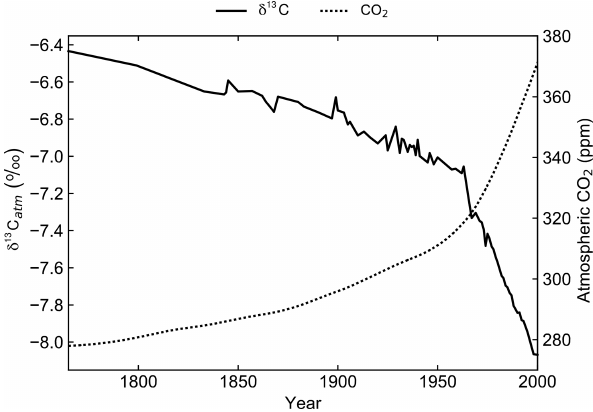
Figure 3. Prescribed atmospheric δ 13 C values (solid) from the Law Dome and South Pole ice core records (Rubino et al., 2013) and pre- scribed atmospheric CO 2 values (dashed) from the OCMIP-2 files (Orr et al.,